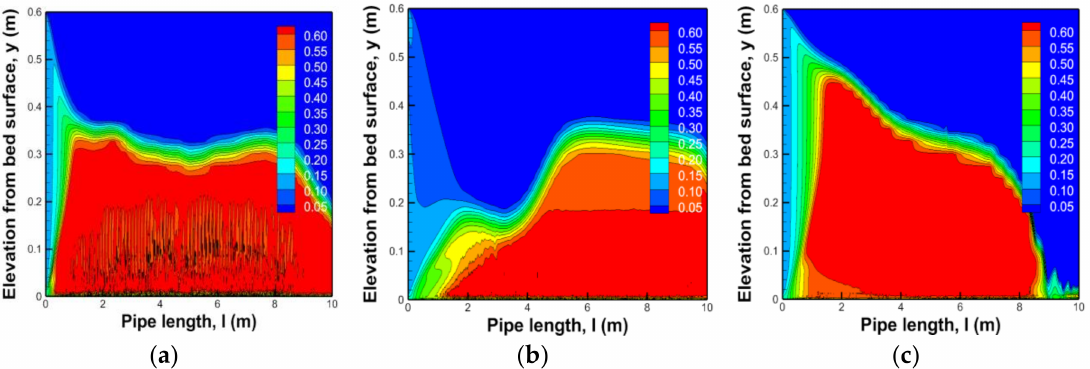
Figure 9. Sedimentation results for soil of diameter 20.0 mm according to changes in inlet velocity.